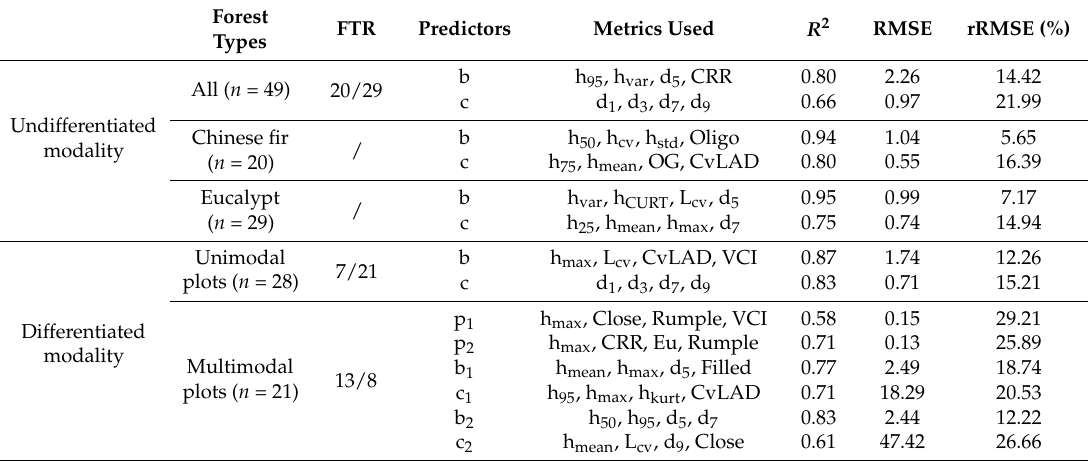
Table 5. A summary statistics for predictive